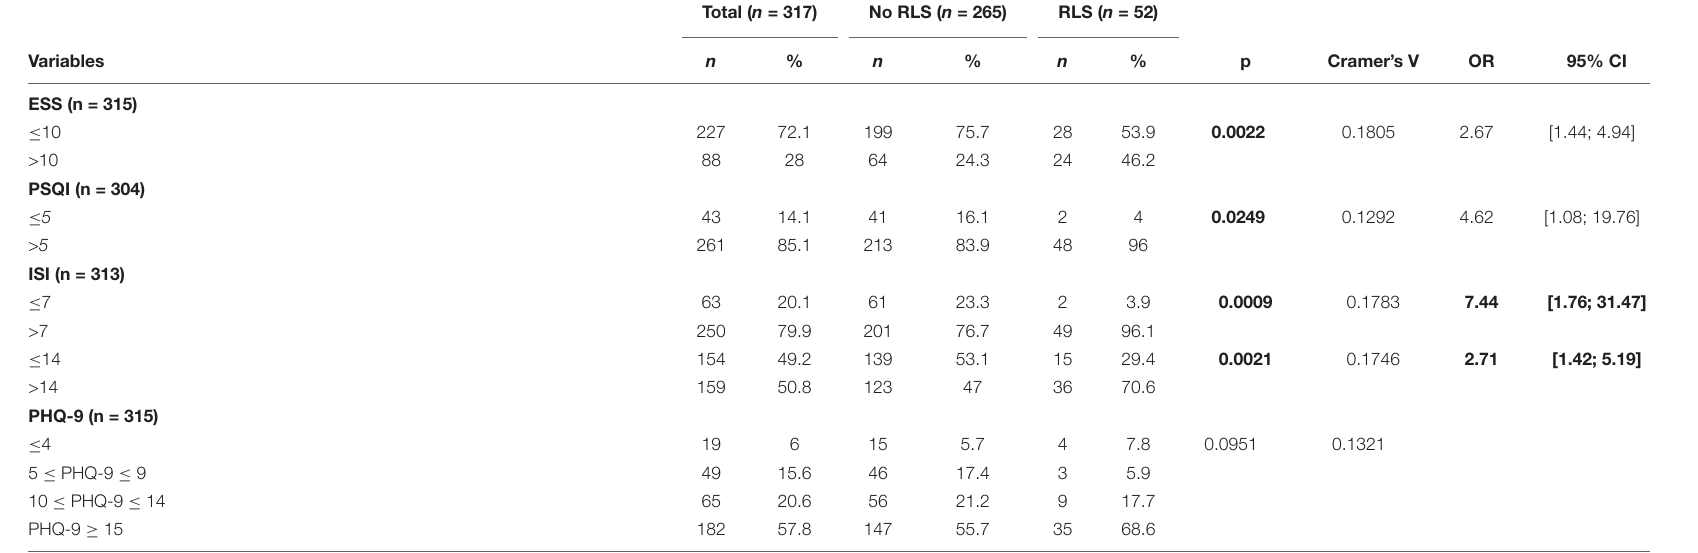
F51.2: Non-organic disorder of the sleep-wake schedule; F51.3 Sleepwalking (somnambulism); F51.4Sleep terrors (night terrors); F51.5: Nightmares; G25.80: Periodic leg movements in sleep; G47.0: Disorders of initiating and maintaining sleep (insomnias); G47.1: Disorders of excessive somnolence (hypersomnias); G47.2: Disorders of the sleep-wake schedule; G47.3: Sleep apnea; G47.4: Narcolepsy and cataplexy;